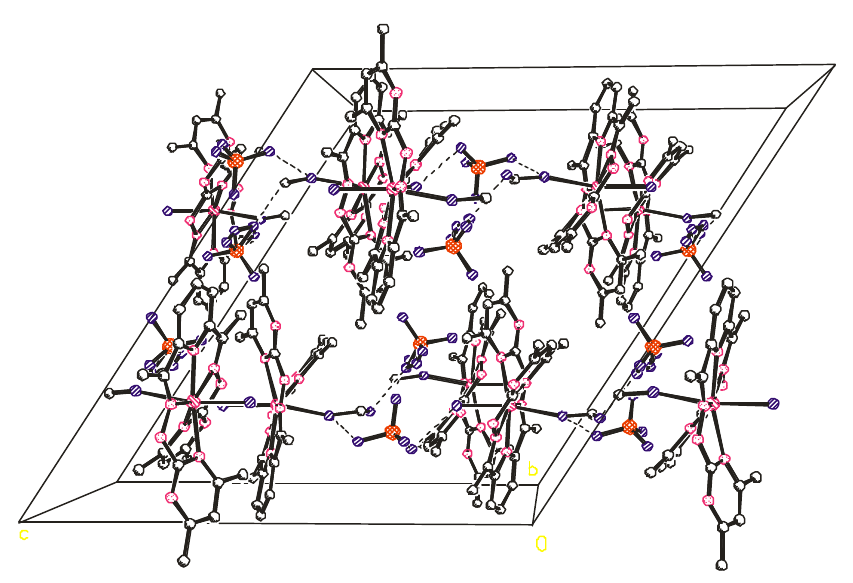
Figure 2. Fragment of the crystal packing in 1 .